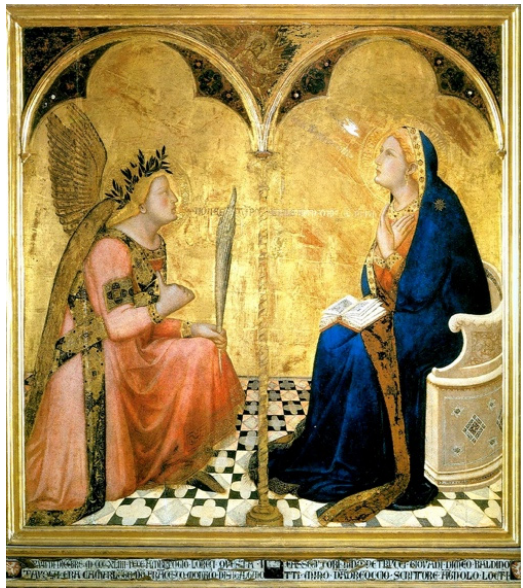
Figure 13. Ambrogio Lorenzetti, Annunciation , panel. Siena, Pinacoteca (photo source: Public domain, via Wikimedia Commons).